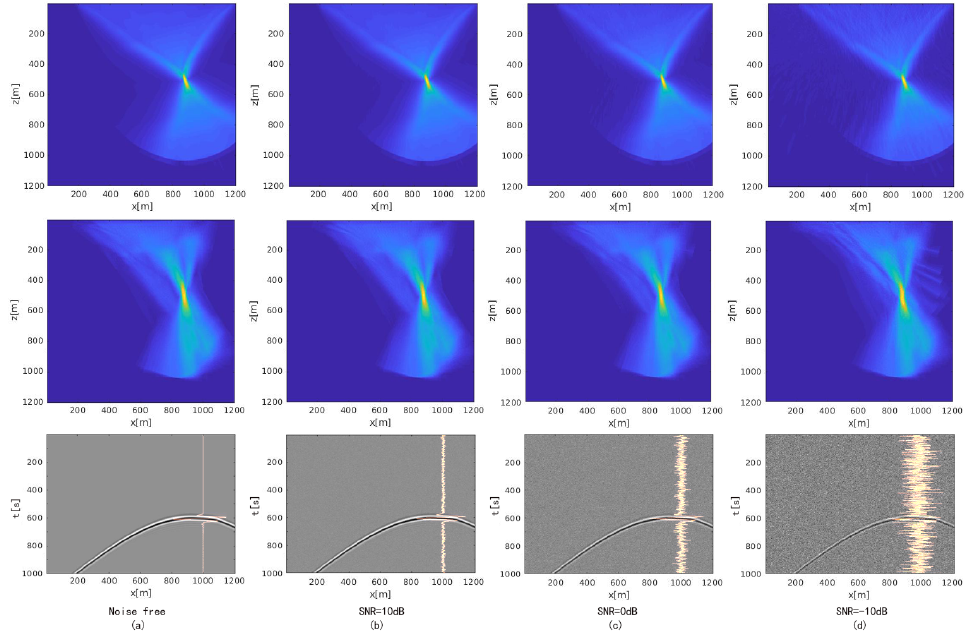
Figure 12. The FDTD-TRI image ( first row ), the GB-TRI image ( second row ) and the observed data ( third row ) with different SNRs. ( a ) Noise free; ( b ) SNR = 10 dB; ( c ) SNR = 0 dB;( d ) SNR = − 10